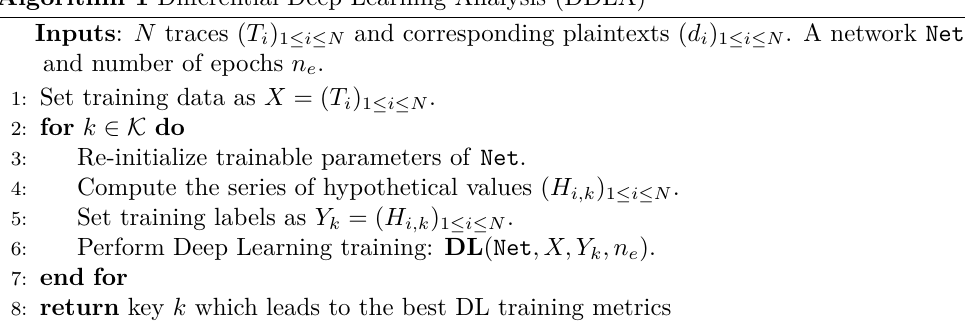
Algorithm 1 Differential Deep Learning Analysis